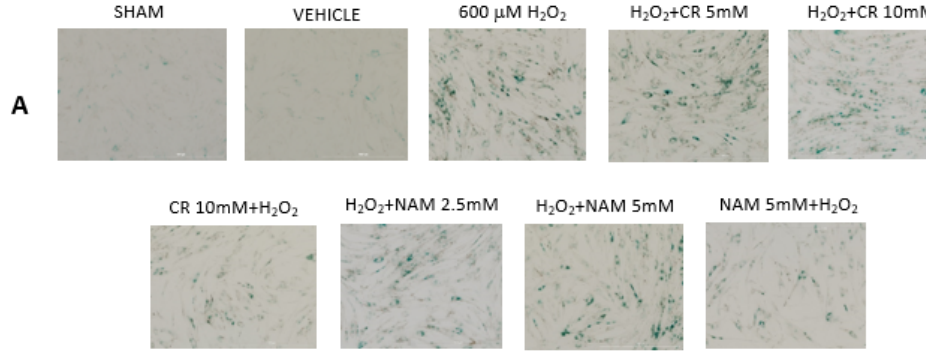
Figure 5. Effect of Cr and NAM on oxidant induced, senescence associated increased SASP cytokine mRNA levels. HDF were exposed to various concentrations of Cr or NAM alone or combined (5 mM each), media alone (SHAM), or water vehicle (1%). After 24 h, the cells were exposed to 600 µM H 2 O 2 for 2 h, followed by harvesting 72 h later ( A – C ). The data are mean ± SE levels of mRNA from various cytokines normalized to actin from 3–4 separate experiments using duplicate samples. Data sets of SASP cytokines were quantified using the Livak method and normalized to sham. * Denotes statistically significant changes in the Cr/NAM treated levels in comparison to H 2 O 2 alone. NS, the treatments compared are not statistically significantly different.